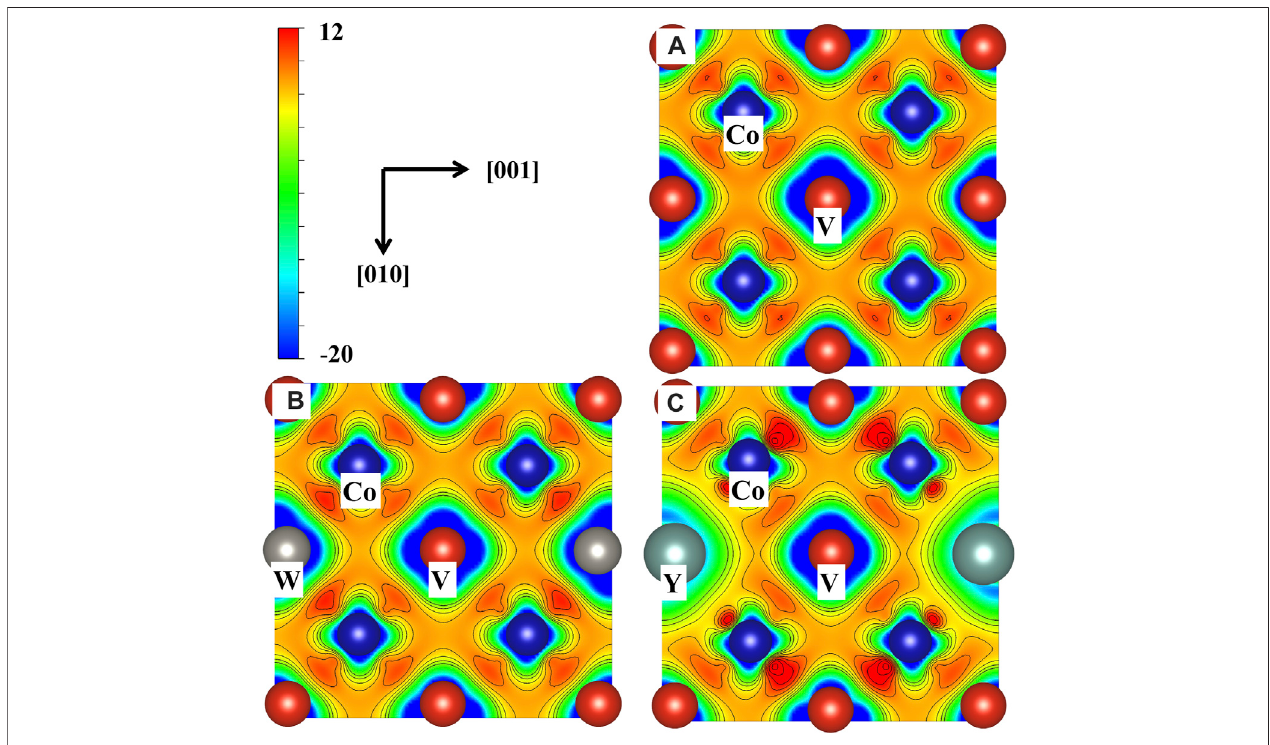
FIGURE 6| Charge density differences (CDD) ofthe γ ′ -Co 3 (V, Ta) phase on the (100) plane of (A) pure, (B) W occupying the Vsite, and (C) Y occupyingthe V site.